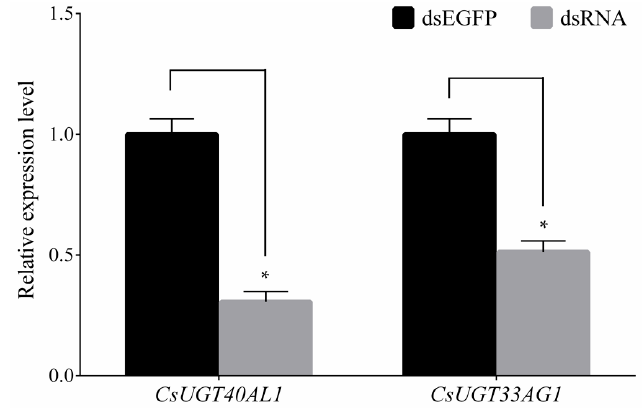
Figure 5. qRT-PCR analysis of UGT gene expression after individual UGT dsRNA injection in YYR of C. suppressalis . Data were normalized to the expression of G3PDH and Actin A1 . Error bars represent the SD from the mean of three independent replicates. There were 30 fourth instar larvae for each biological replicate. Asterisks (*) indicate significant differences between treatments as determined by Student’s t -test ( p < 0.05).